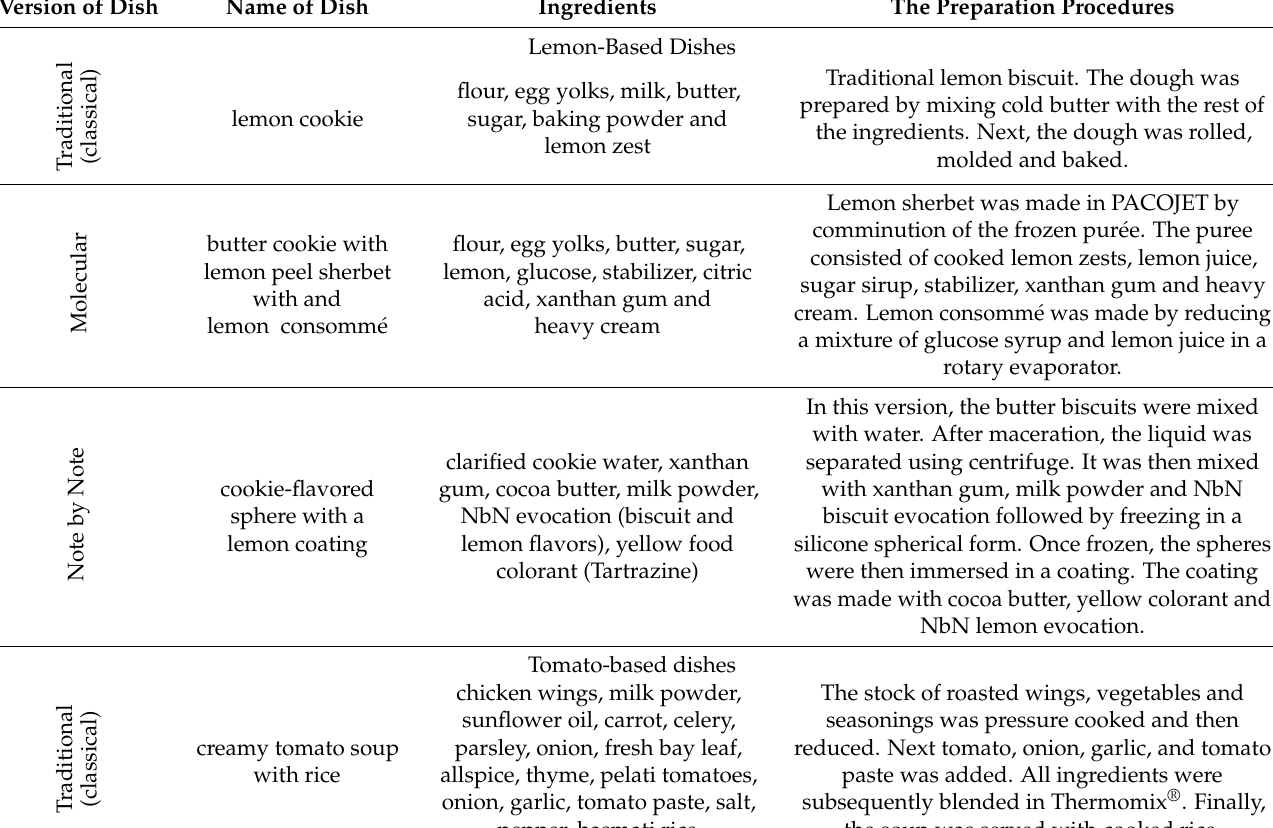
Table A1. The preparation procedures of dishes used in